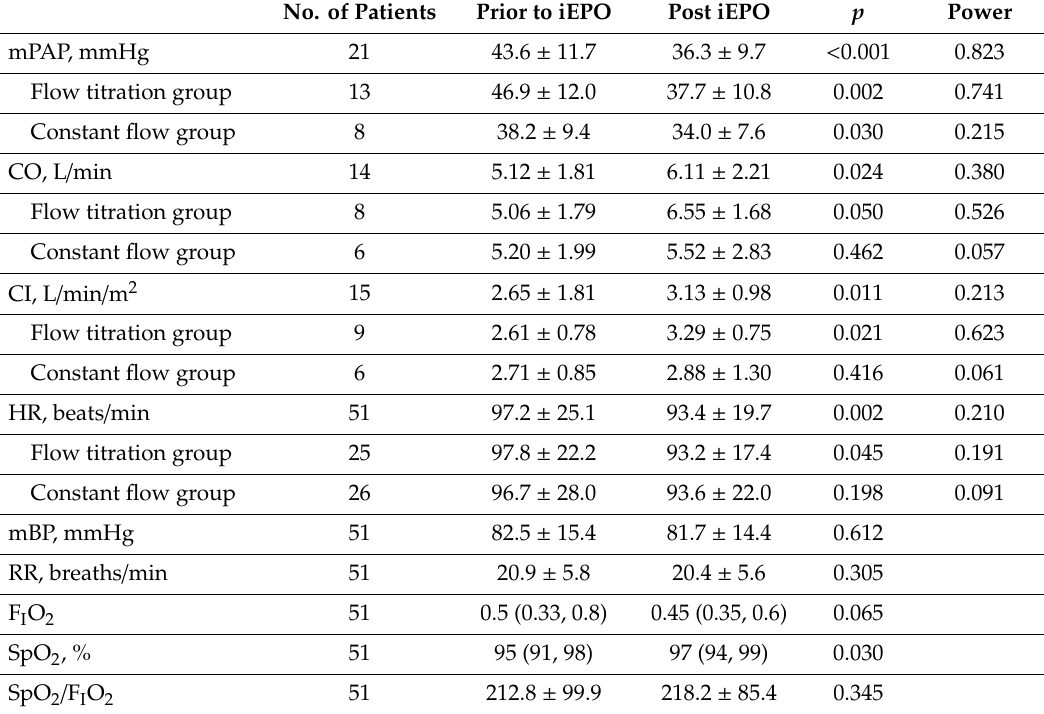
Table 3. Comparison of hemodynamic responses pre and post iEPO for all patients. No. of